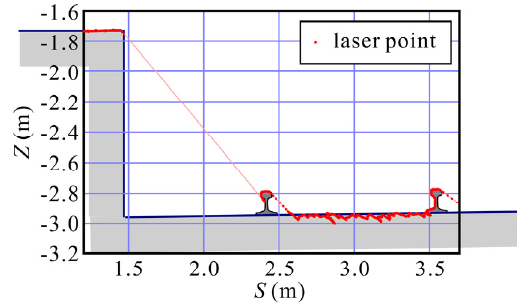
Figure 12. Laser points of the primary scan line C